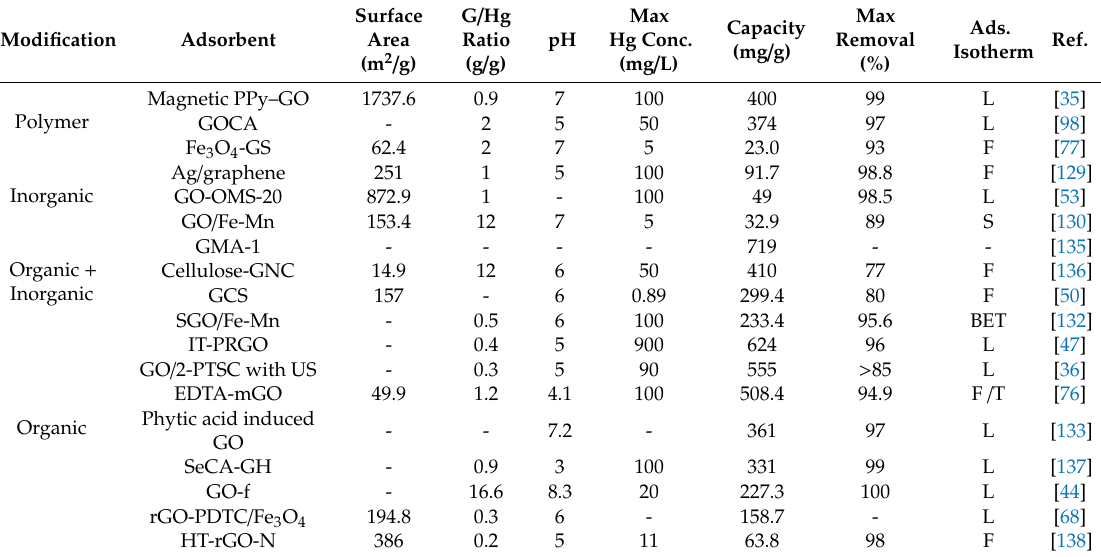
Table 6. Adsorption properties of multiple GO-based adsorbents used in Hg (II) removal. Polymer Modification